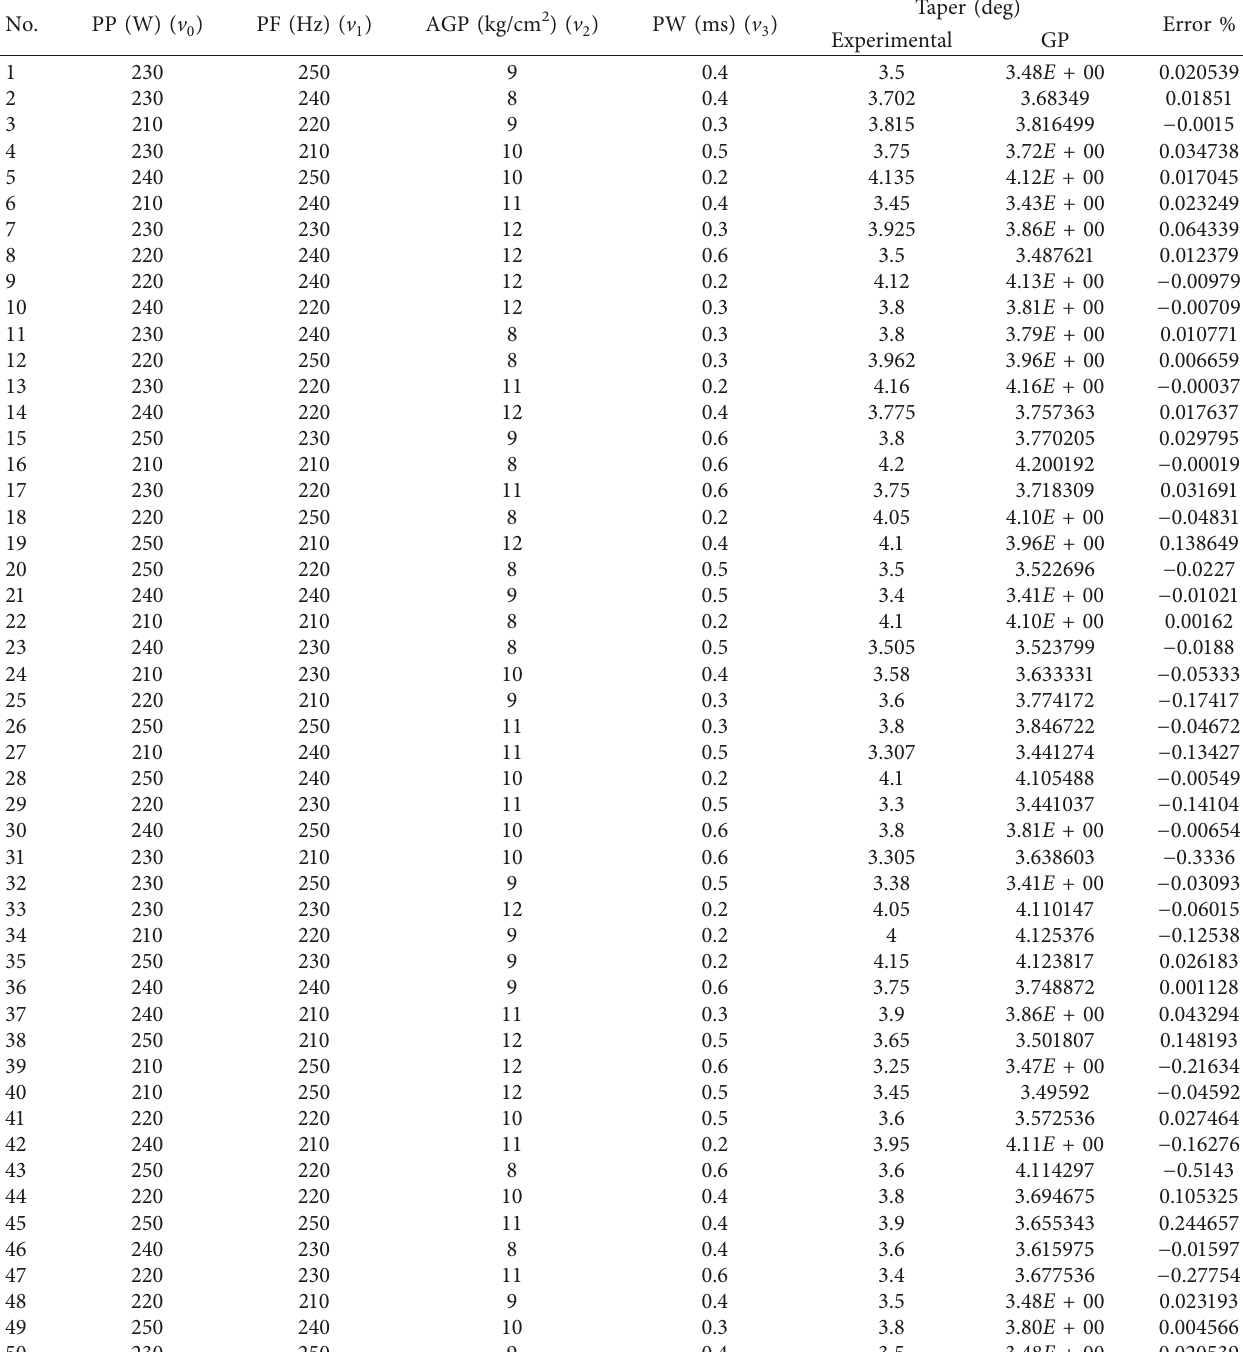
Table 4: Comparison between experimental and predicted values of taper at R 2 �